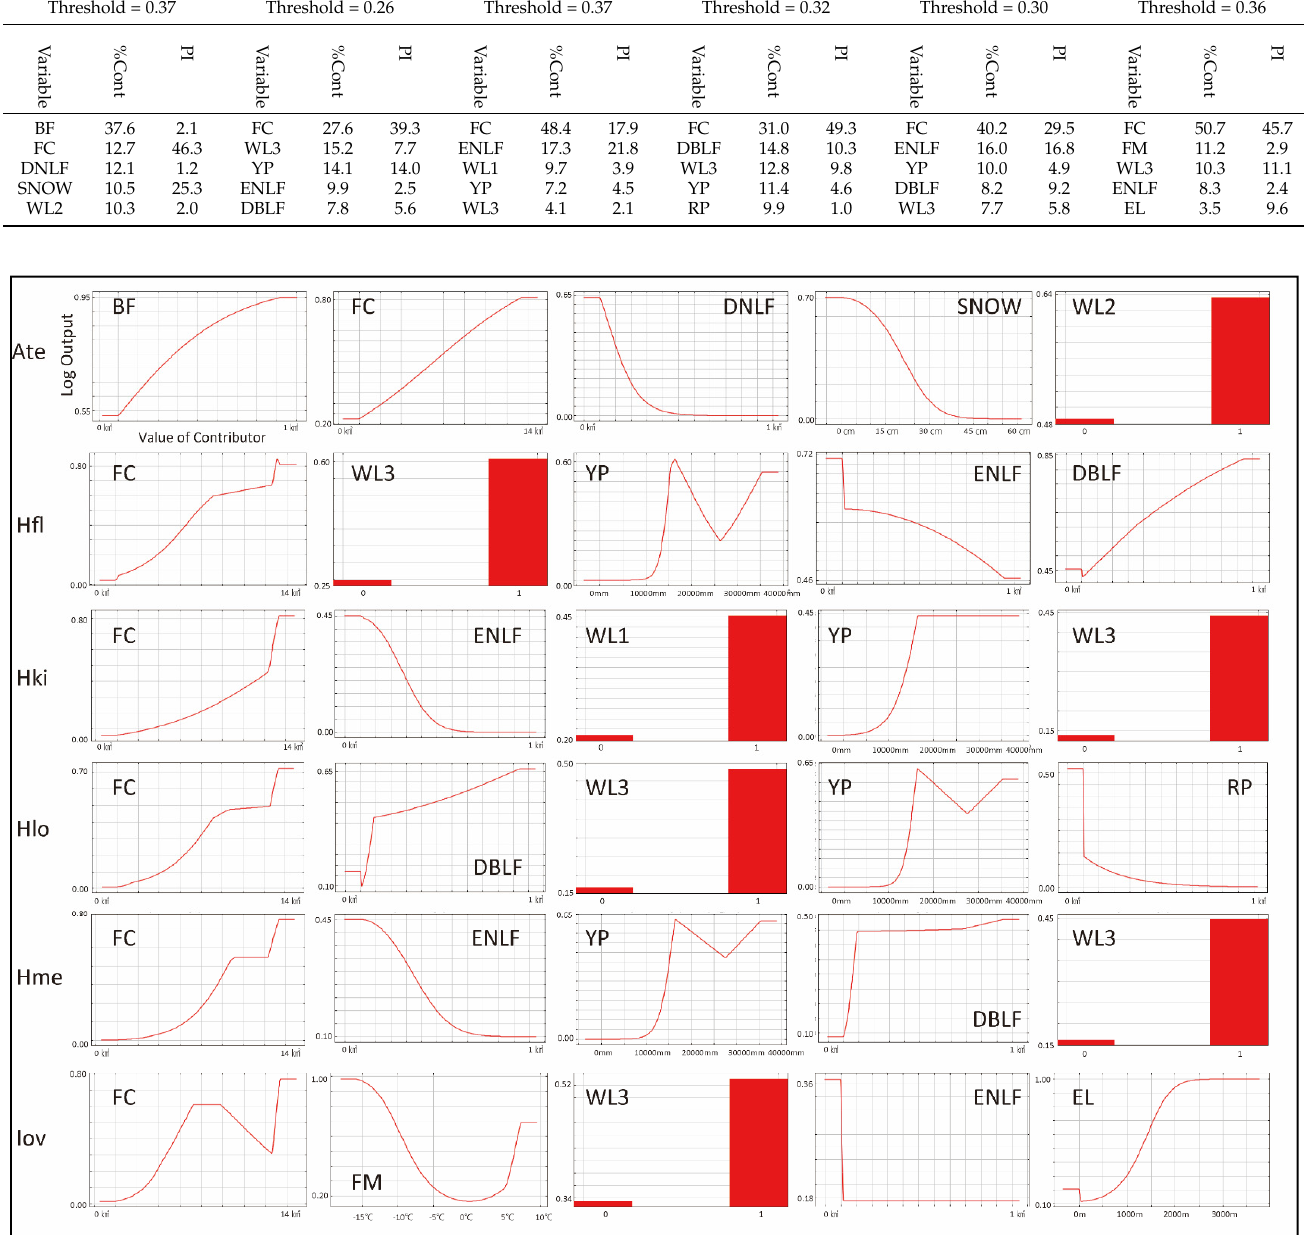
Figure 4. Response curves given by the logistic output for the values of the five variables with the greatest contributions for each tick species: A. testudinarium (Ate), H. flava (Hfl), H. kitaokai (Hki), H. longicornis (Hlo), H. megaspinosa (Hme), and I. ovatus (Iov). The X -axis indicates the value of the variable, and the Y -axis indicates the logistic output, which is the estimated probability of presence in the model. The relative impact for each variable is shown in Table